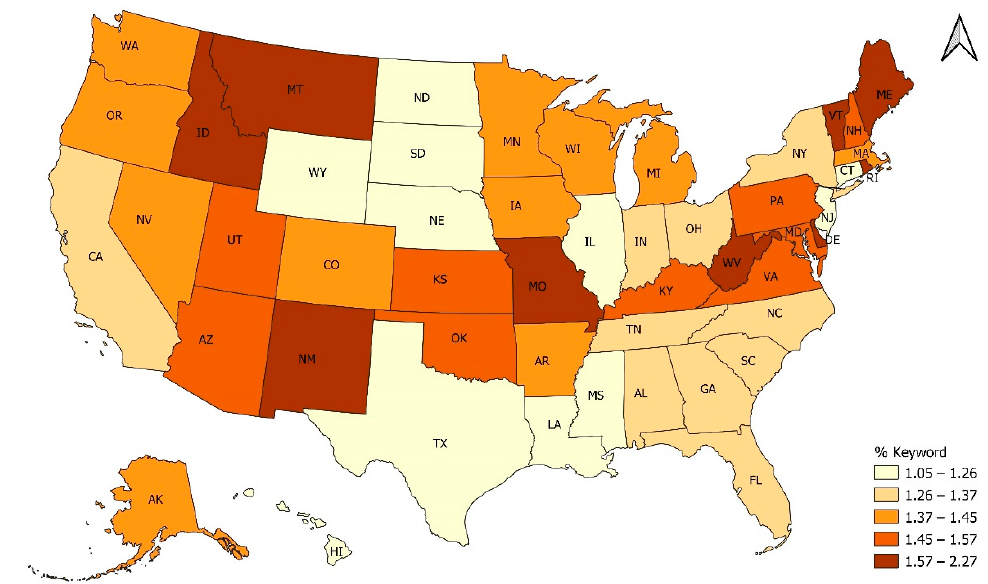
Figure 2. Twitter conversations about Roe v Wade as a percentage of all tweets sent 1 May–15 July 2022 by state.